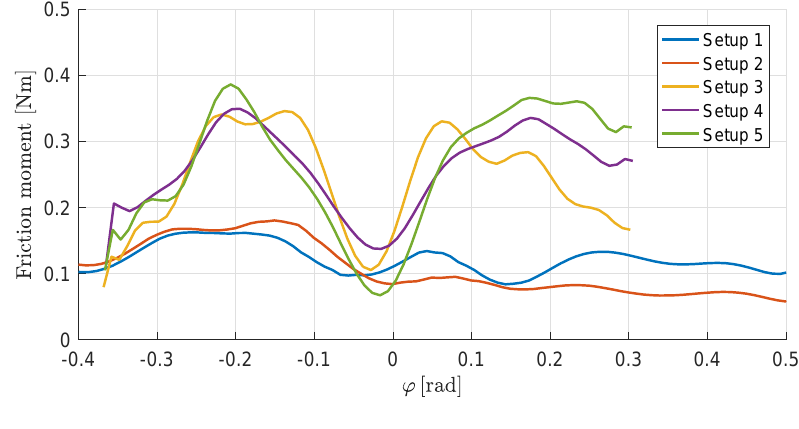
Figure 8. Estimated static friction torque for the different system configurations.